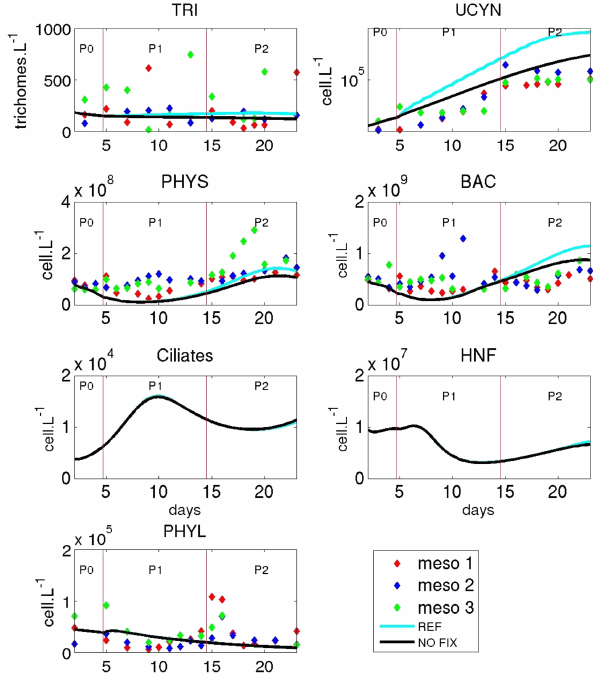
Figure 7. Evolution of plankton abundances (cells L − 1 ) in the REF simulation (blue line) and the NOFIX simulation (black line; i.e. when the N 2 fixation process is removed). TRI: Trichodesmium spp., UCYN: UCYN-C, BAC: heterotrophic bacteria, PHYS: small phytoplankton, HNF: heterotrophic nanoflagellates.